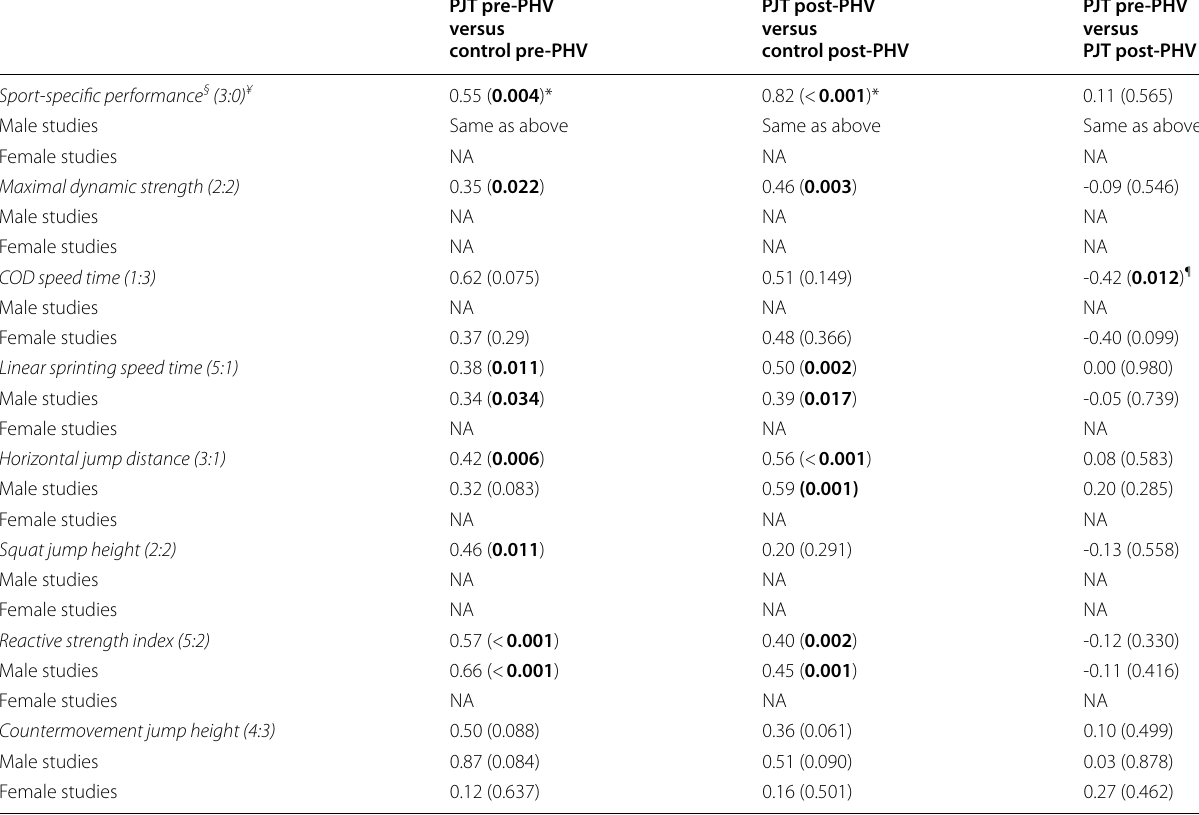
Table 5 Effect size and p‑values derived from